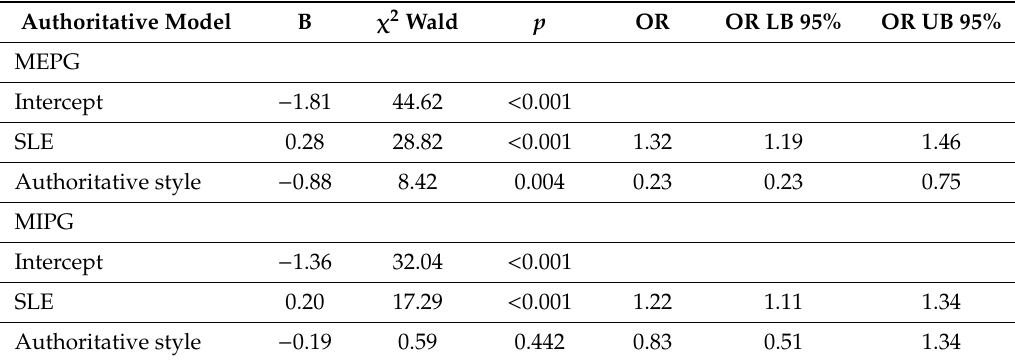
Table 4. Multinomial logistic regression model parameters using the AG as a reference and authoritative style as covariate.